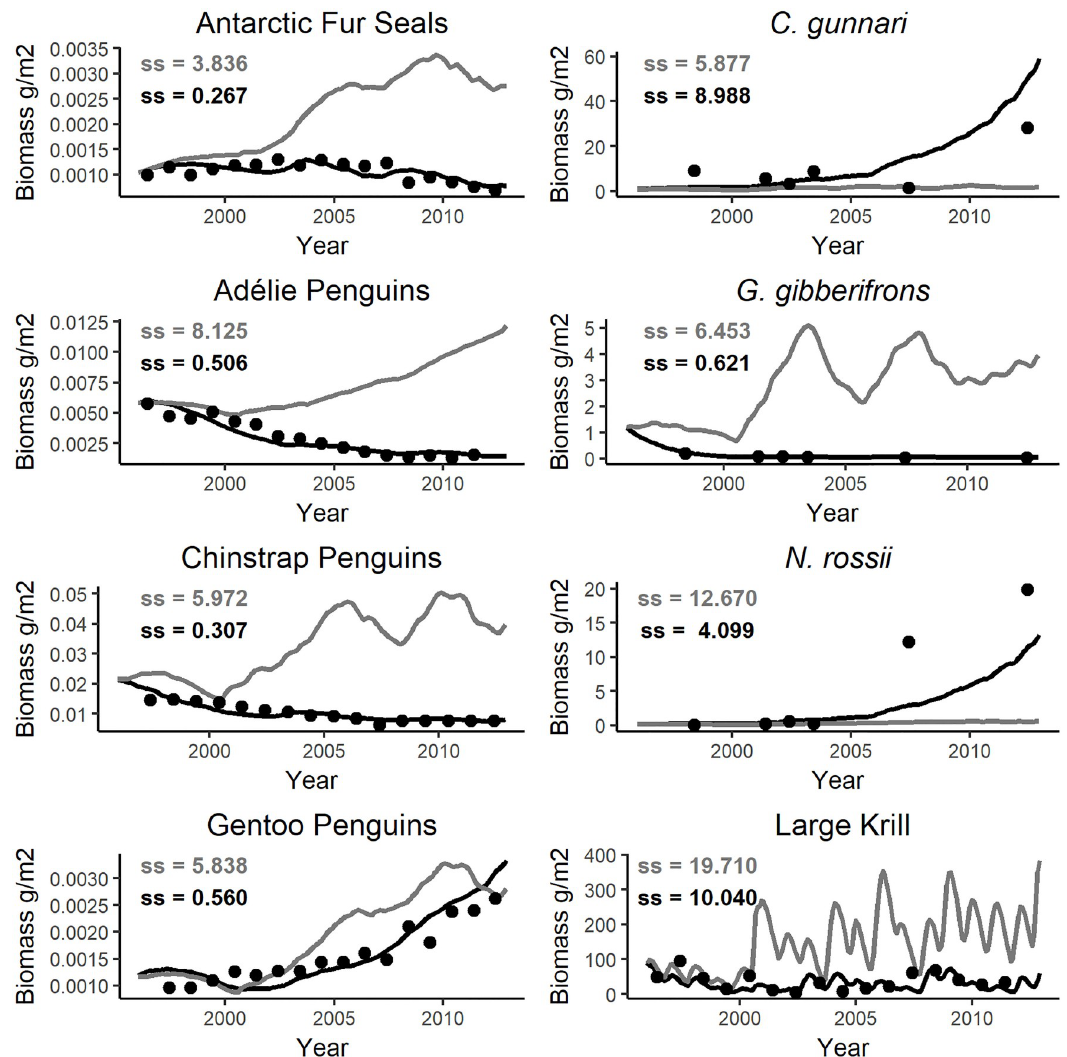
Fig 8. Results of Ecosim simulations. Biomass time series are plotted as black points. The relative biomass results from the model are plotted as lines. Simulations without sea-ice forcing are shown in grey; simulations with sea-ice forcing are shown in black. The group-specific sum of squares (SS) difference between simulation results and observed data are shown for each